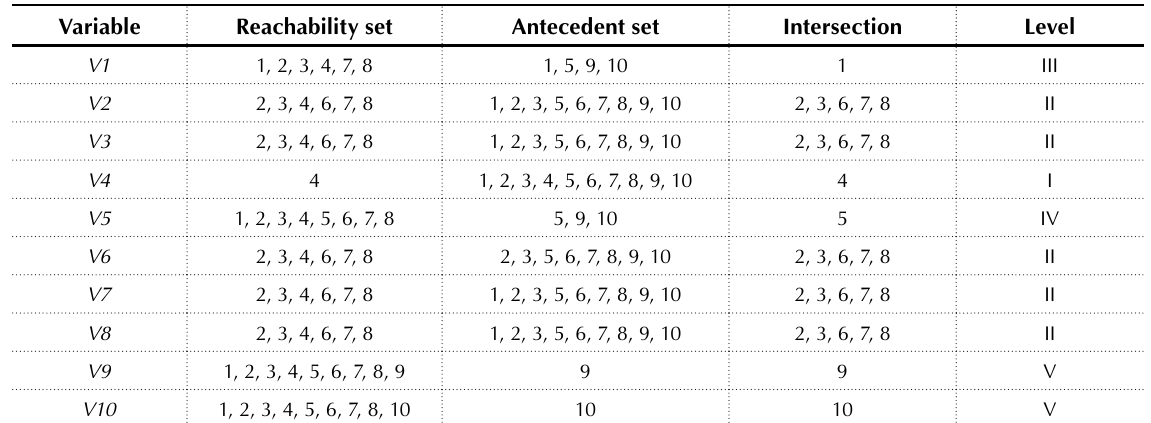
Table 7. Partitioning of